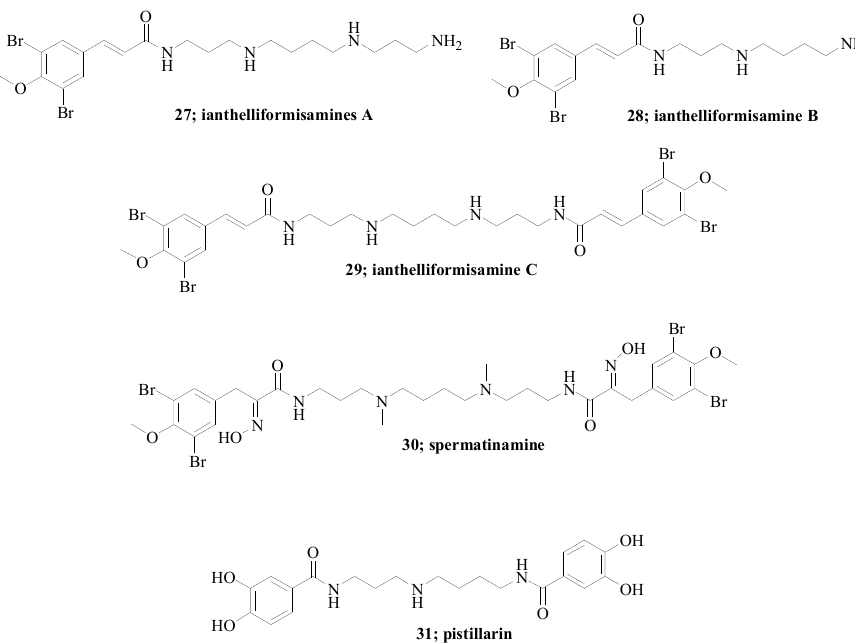
Figure 6. Structures of spermidine secondary metabolites 27 – 31 [11].